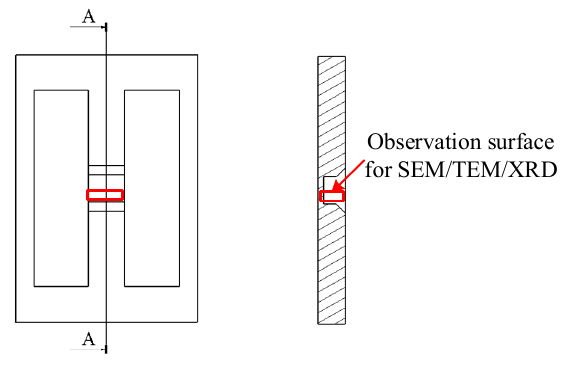
Figure 5. Sketch of the specimen location for SEM/TEM/XRD.